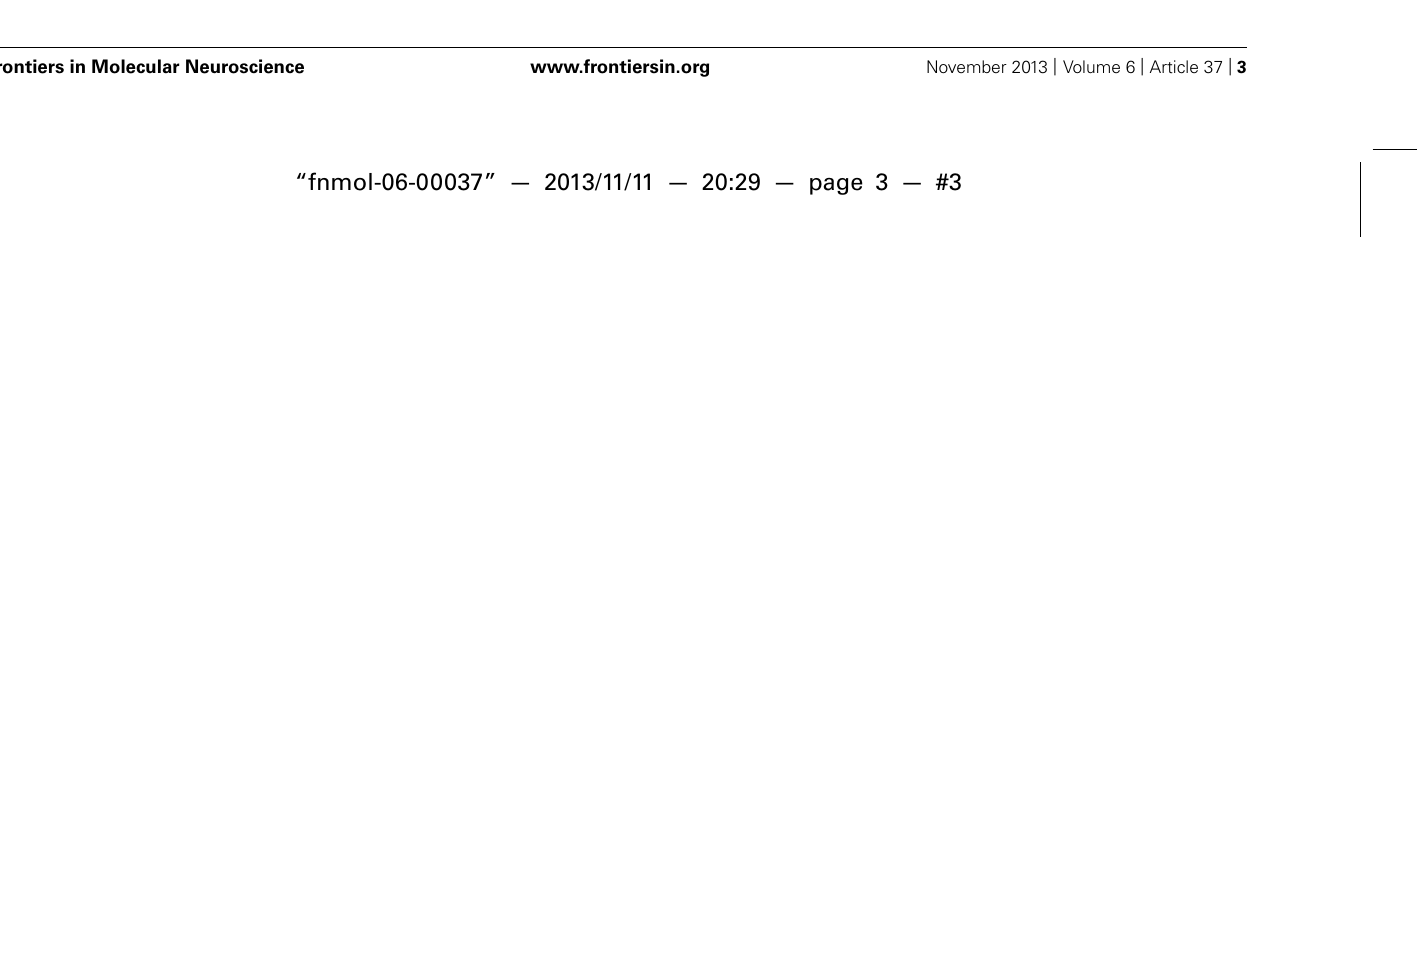
FIGURE 1 | (A) Cartoon showing the site and mechanism of miRNA targeting to mRNA. Figure highlights the seven nucleotide “seed” region critical for miRNA binding to the mRNA target. Additional binding also determines specificity and potency. Alignment is facilitated by initial miRNA loading into the RISC which contains Ago2 and GW182 proteins. Binding typically occurs within the 3 (cid:3) UTR. The result is either degradation of the mRNA target or inhibition of translation. (B) Cartoon depicting scheme